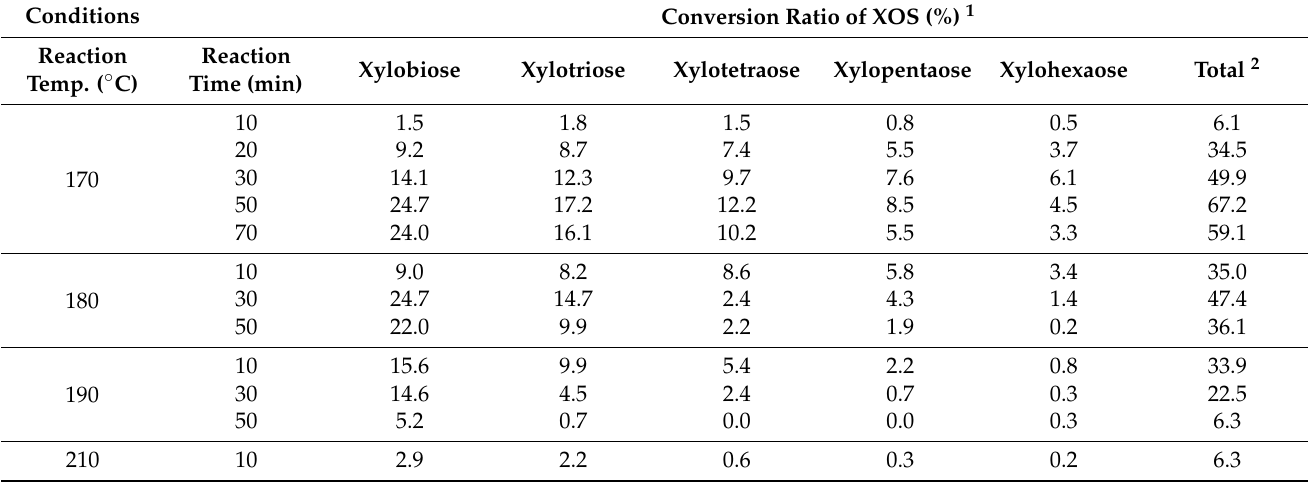
Table 3. Conversion ratio (%) of XOS in the liquid hydrolysate after LHW treatment.